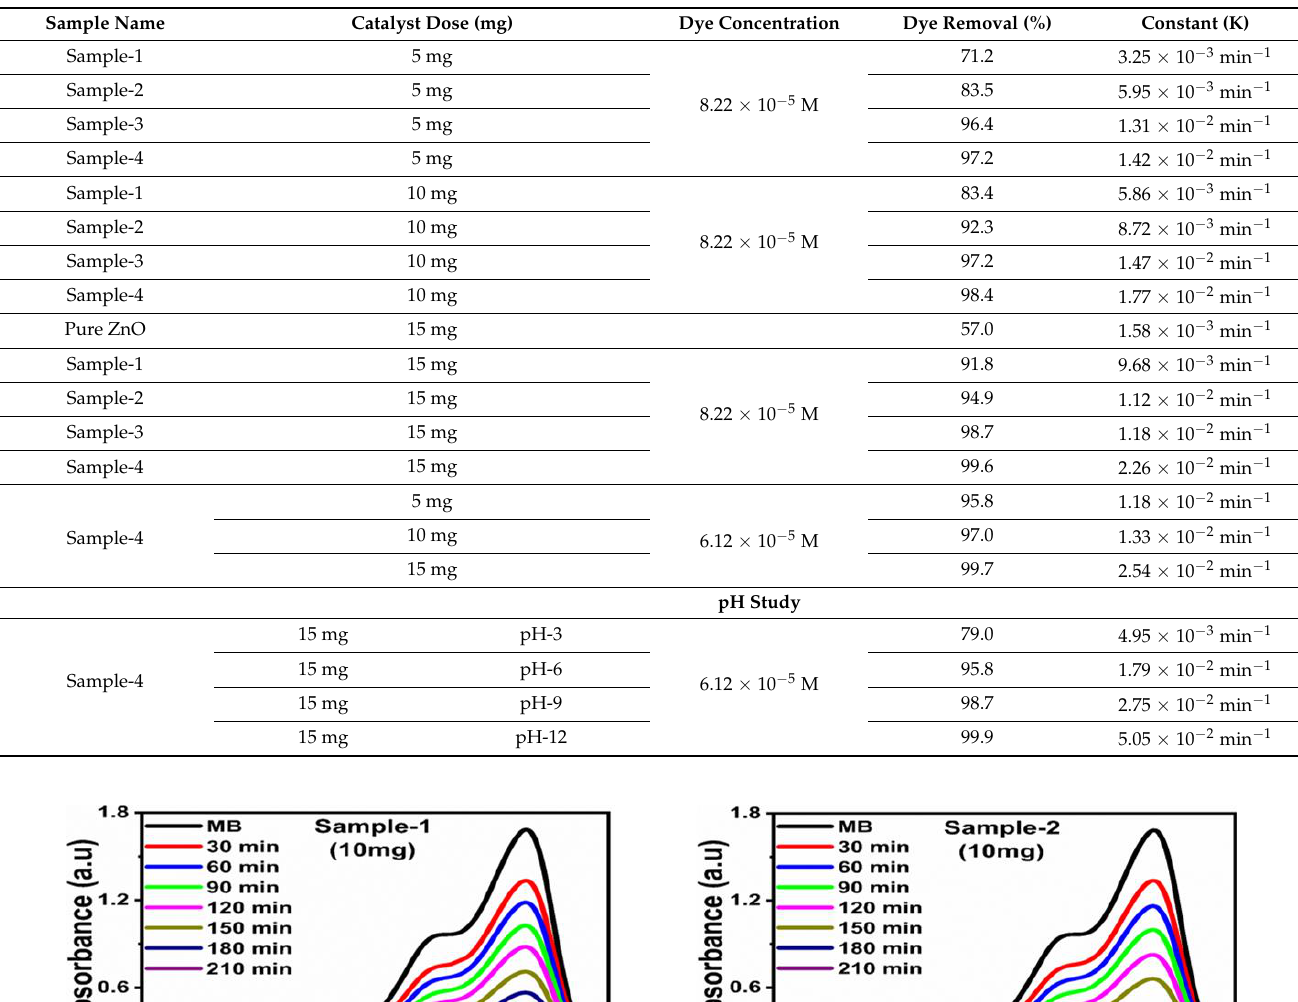
Table 2. Summarized performance evaluation of pure ZnO and green synthesized ZnO samples against the dye removal of MB under sunlight irradiation.